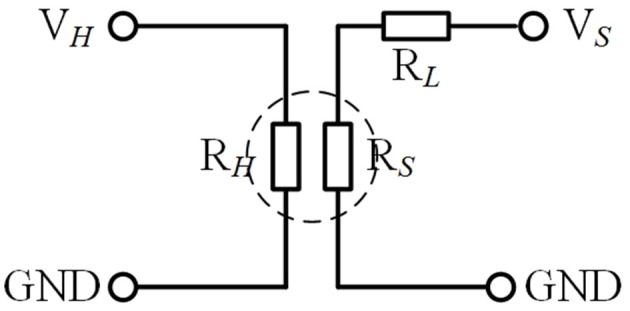
The test circuit.